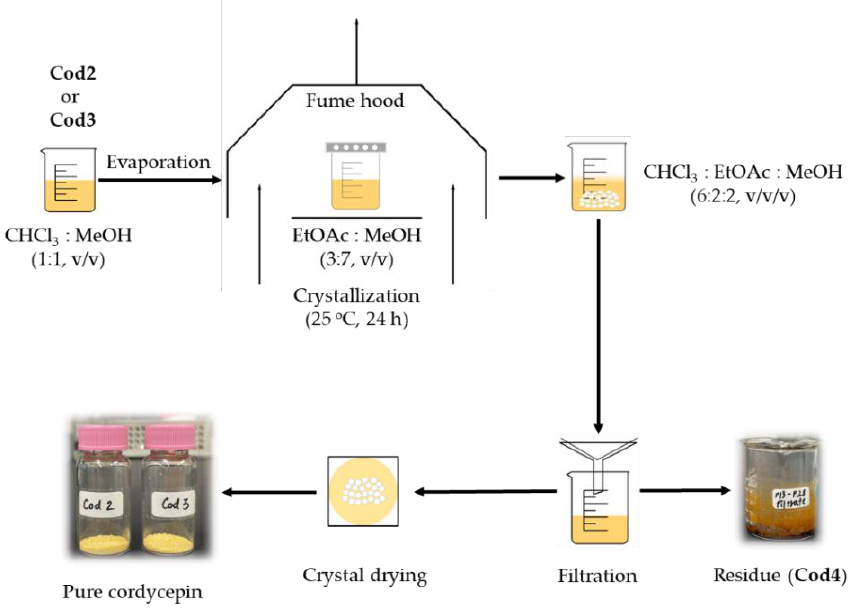
Figure 3. Crystallization and purification of cordycepin from fractions Cod2 and Cod3 .